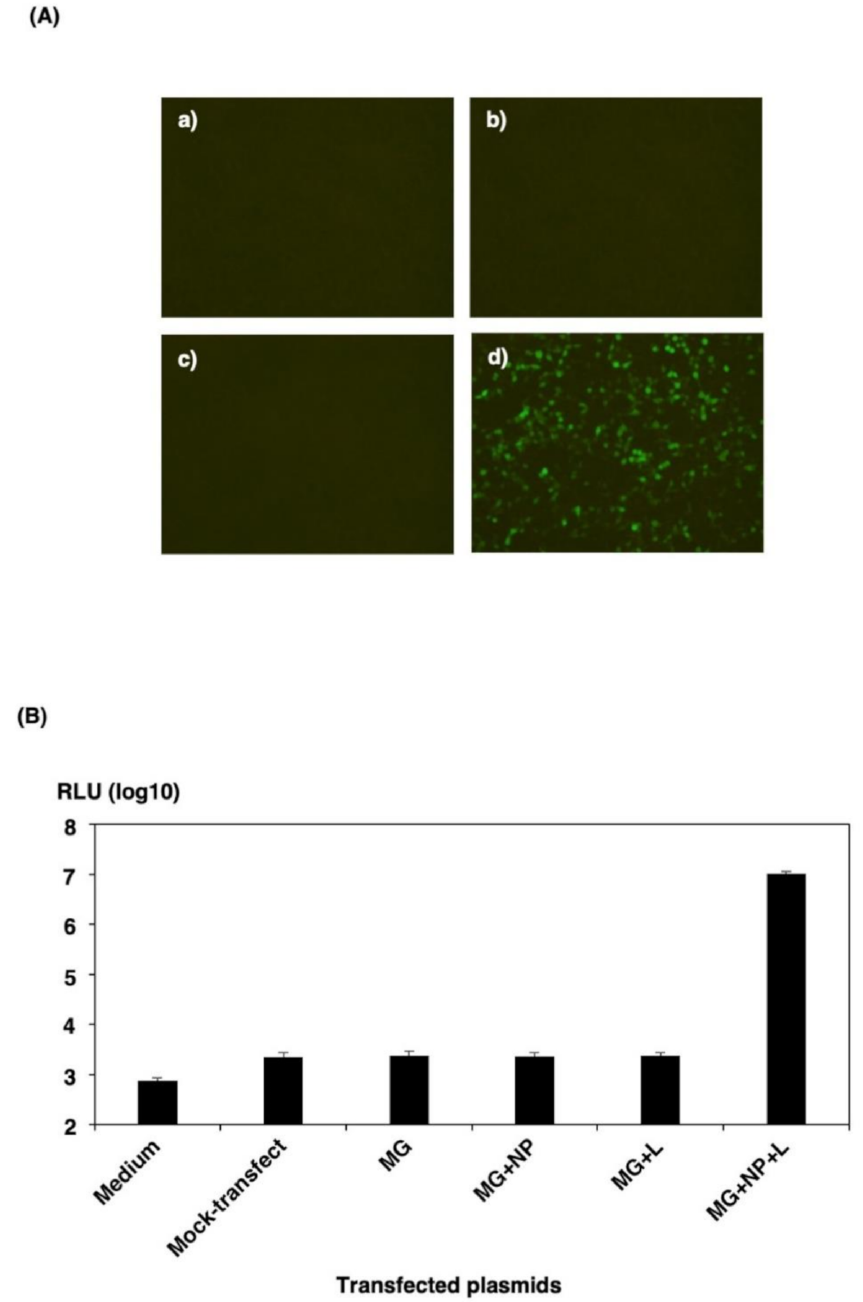
Figure 2. Reporter gene expression from cRNA-oriented pol I-driven minigenome. 293T cells in a 12-well plate were transfected, each with 300 ng of pPolIV-SFTSV-M-eGFPHBT (MG), 300 ng of pKS-SFTSV-NP, and 150 ng of pKS-SFTSV-L plasmid per well. ( A ) 293T cells were transfected with the MG ( a ), MG and pKS-SFTSV-NP ( b ), MG and pKS-SFTSV-L ( c ), or MG, pKS-SFTSV-NP, and pKS-SFTSV-L ( d ) and analyzed 48 h post-transfection for expression of eGFP-HBT by fluorescence microscopy. ( B ) 293T cells were either transfected with empty vector (mock-transfection) or trans- fected with the MG, MG and pKS-SFTSV-NP (MG + NP), MG and pKS-SFTSV-L (MG + L), or MG, pKS-SFTSV-NP, and pKS-SFTSV-L (MG + NP + L). The minigenome activity of eGFP-HBT expres- sion was assayed by measuring the luciferase activity 32 h post-transfection using the Nano-Glo HiBiT Lytic Detection System. The results shown are for three independent assays, with error bars representing standard